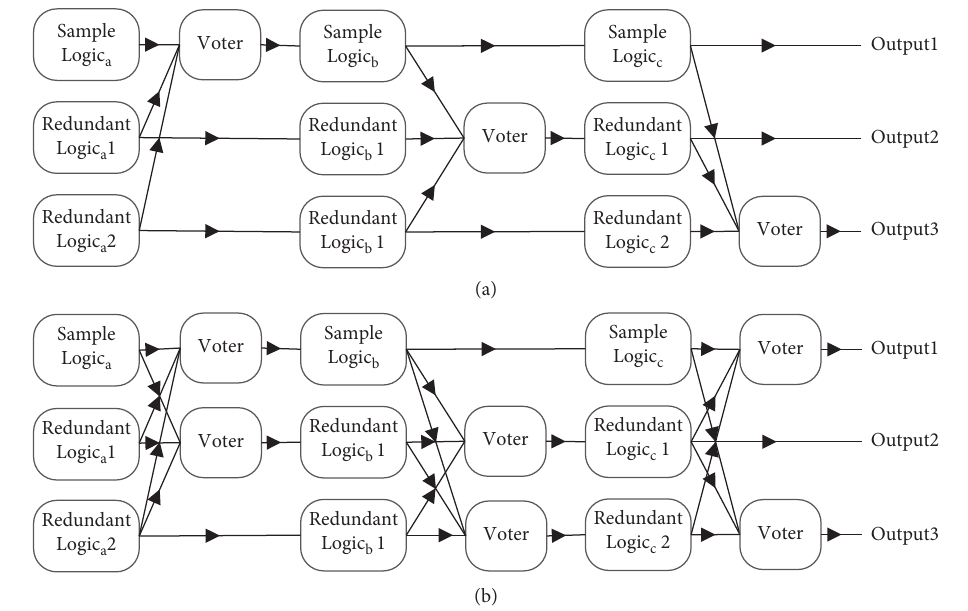
Figure 2: TMR with (a) one alternate voter and (b) two alternate voters.